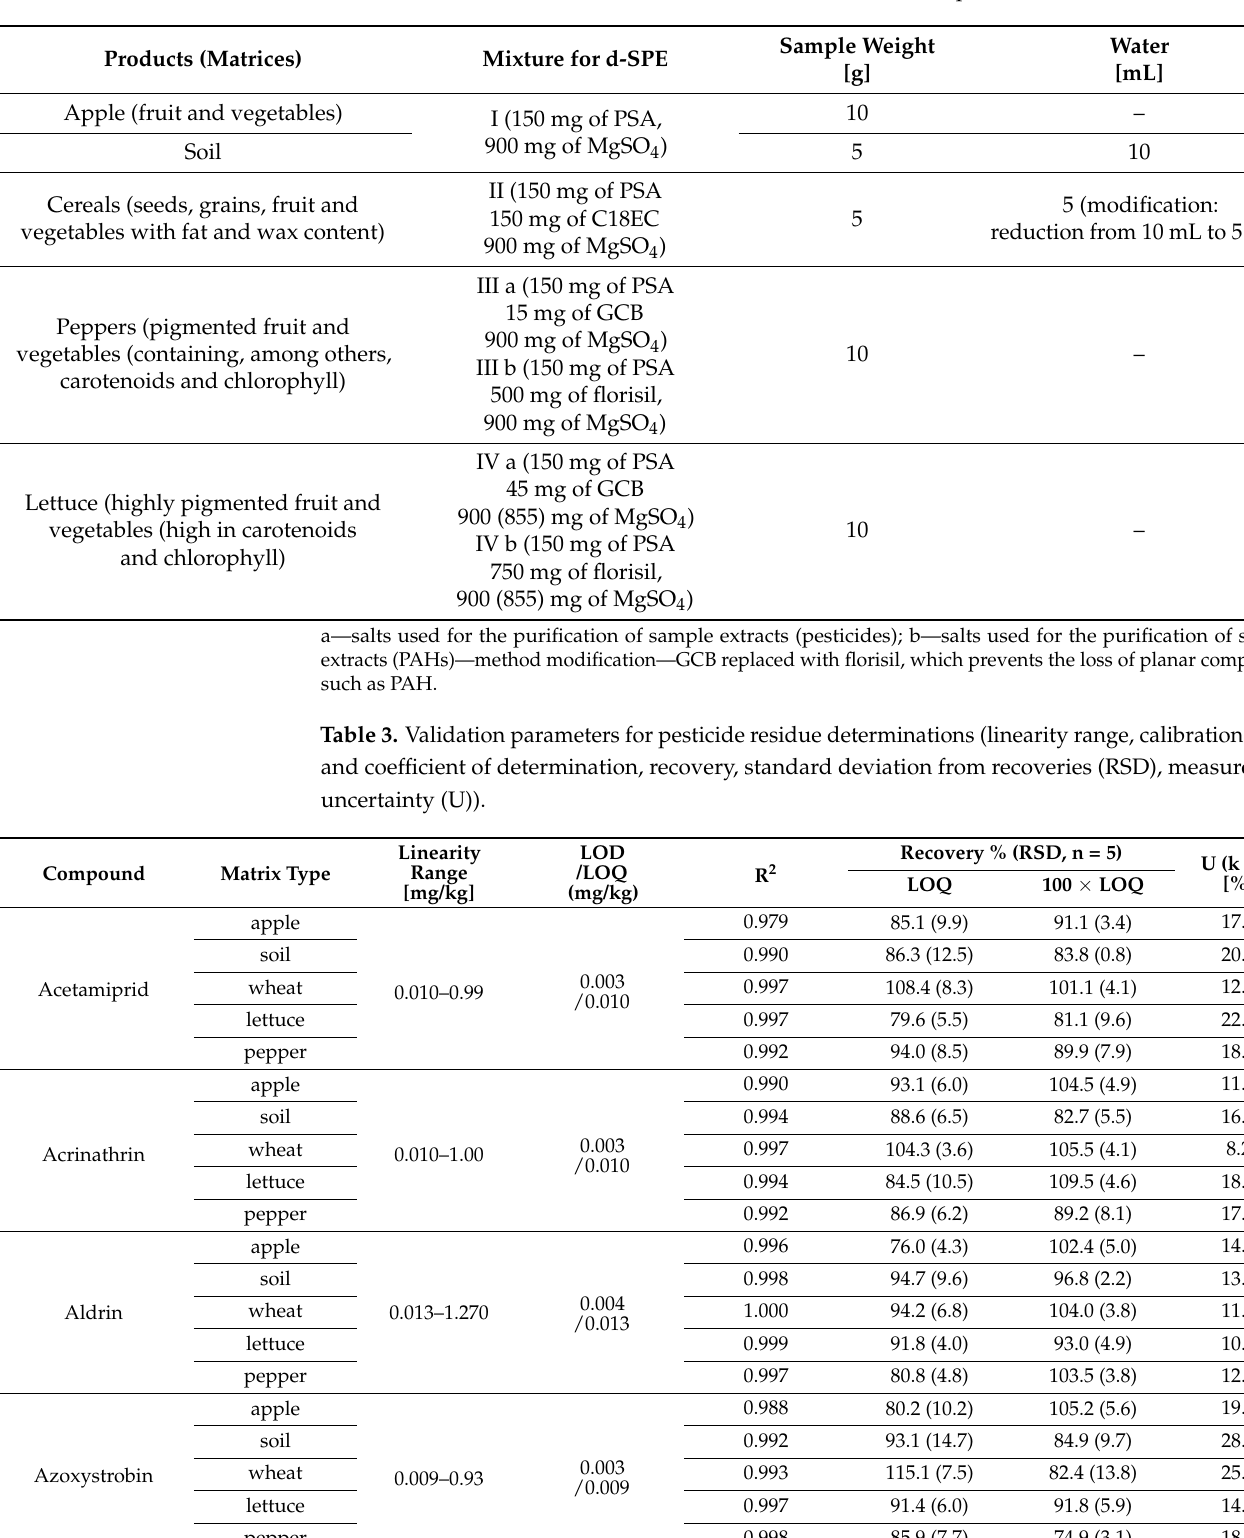
Table 2. List of salts and sorbents used for extraction and cleanup of individual matrices.